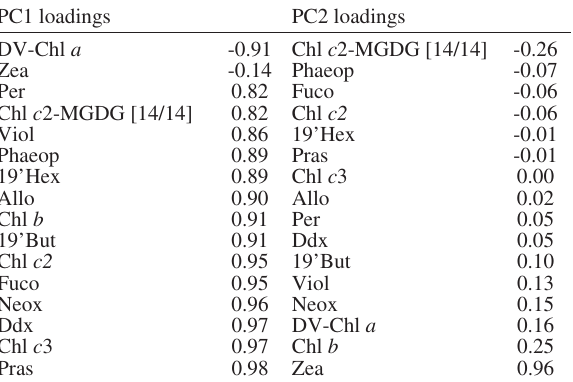
Table 4. – Correlation coefficients (loadings), ordered by magnitude, of the two first principal components on the 16 pigment descriptors. PC1 loadings